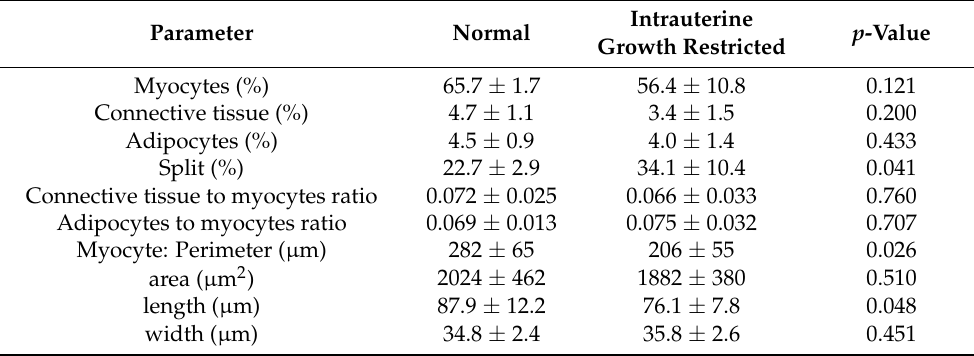
Table 6. Histometric analysis of the ultrastructure of the longissimus dorsi muscle and single myocyte of the normal ( n = 12) and intrauterine growth restricted ( n = 11) pigs. The percentage of myocytes, connective tissue, and adipocytes in the field of vision (values do not add to 100% because of the 1–2% of the blood and lymphatic vessel cells and nerve fibres and the split between the groups of muscle fibres), and ratios between the cell types. Mean ± SD, Student- t